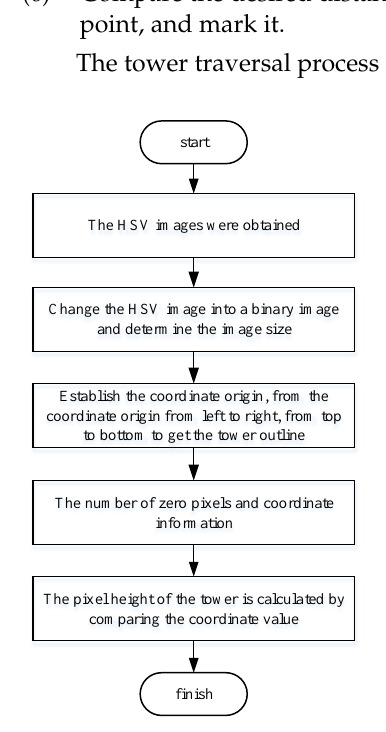
Figure 9. Pole and tower pixel coordinate traversal process.